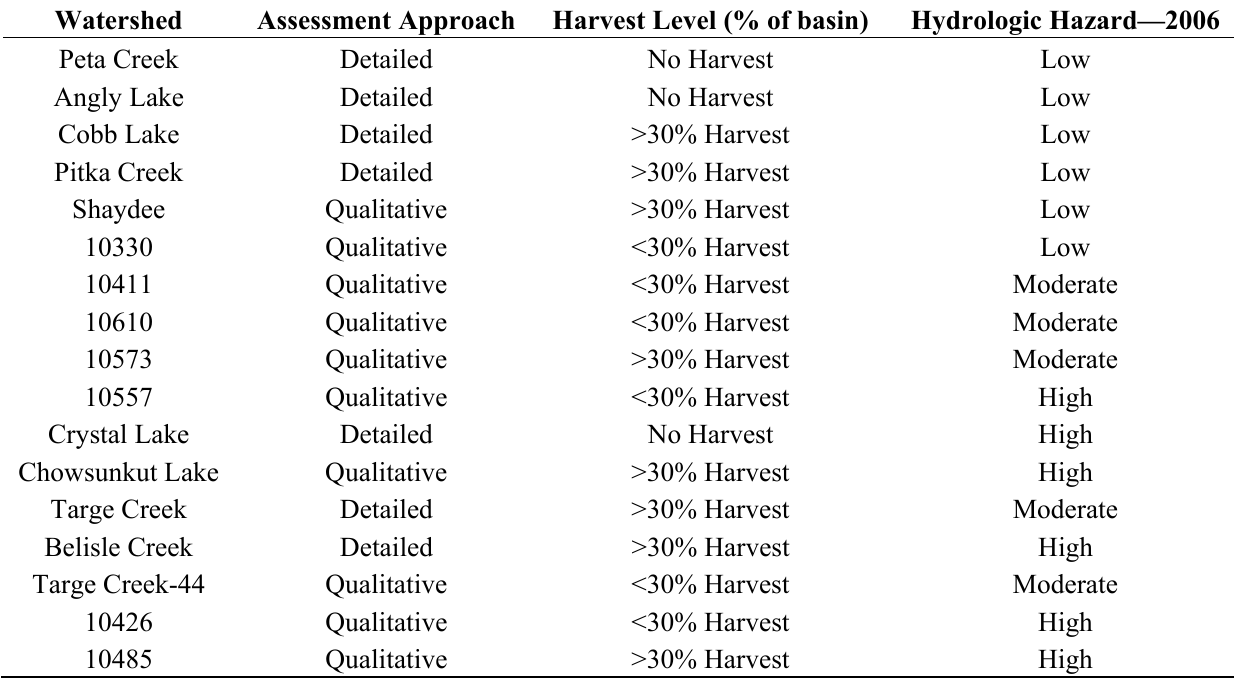
Table 2. The a priori predicted hydrologic hazard for studied watersheds, their harvest level and the assessment approach used in